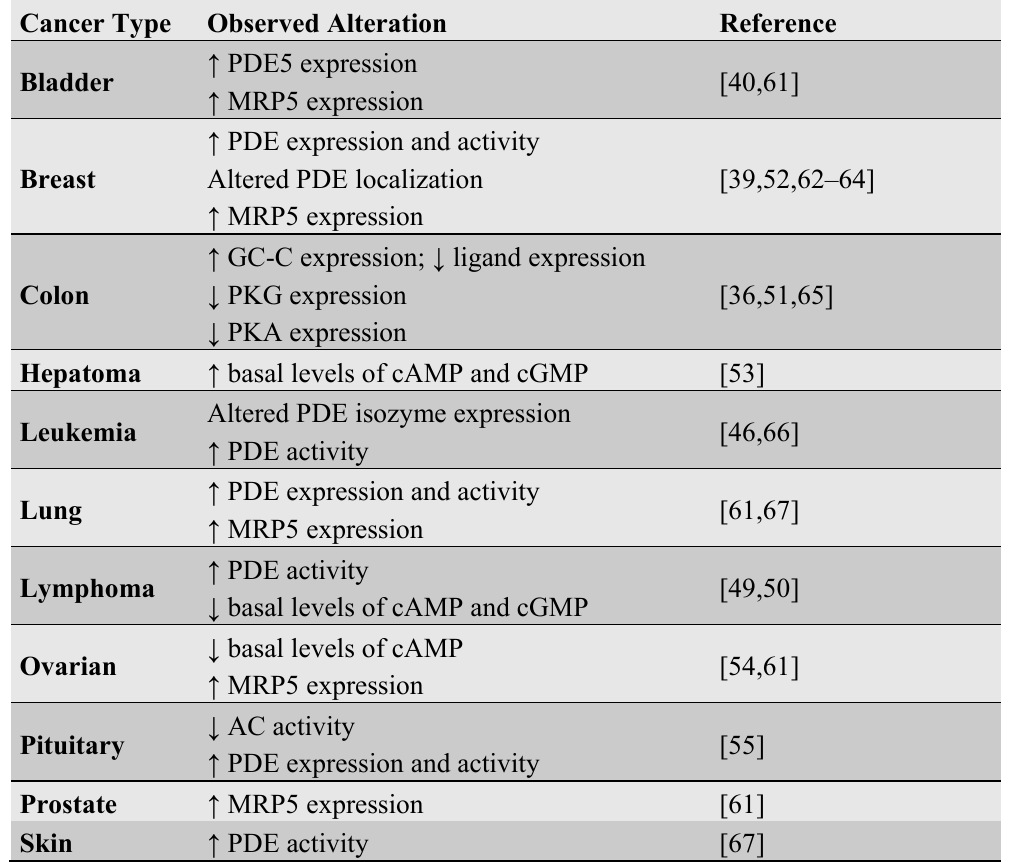
Table 2. General overview of reported alterations of cyclic nucleotide signaling and down-stream effectors in select cancer types. Changes in expression and/or activity are indicated as; ↑ refers to increase, whereas ↓ refers to